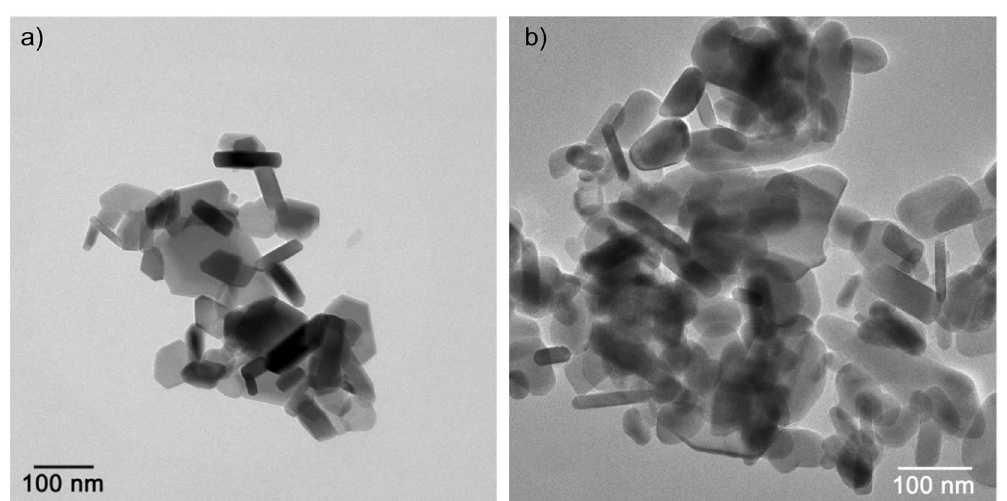
Figure 5. ( a ) TEM image of MSG synthesised SrFe 12 O 19 with the Fe 3 + :Sr 2 + molar ratio 9 (MSG9). ( b ) TEM image of MSG300 where 300% extra NaCl was added to the